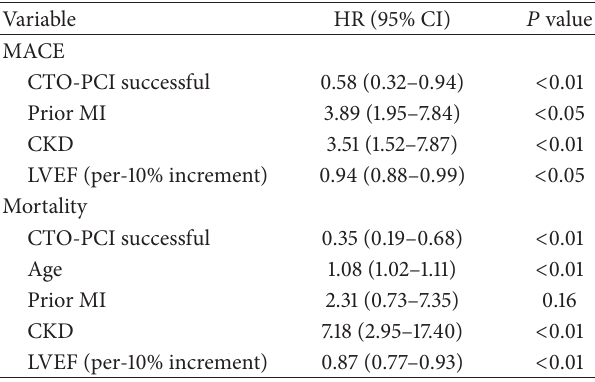
Table 6: Multivariate analyses of predictors for cardiac mortality and MACE-free survival of patients with